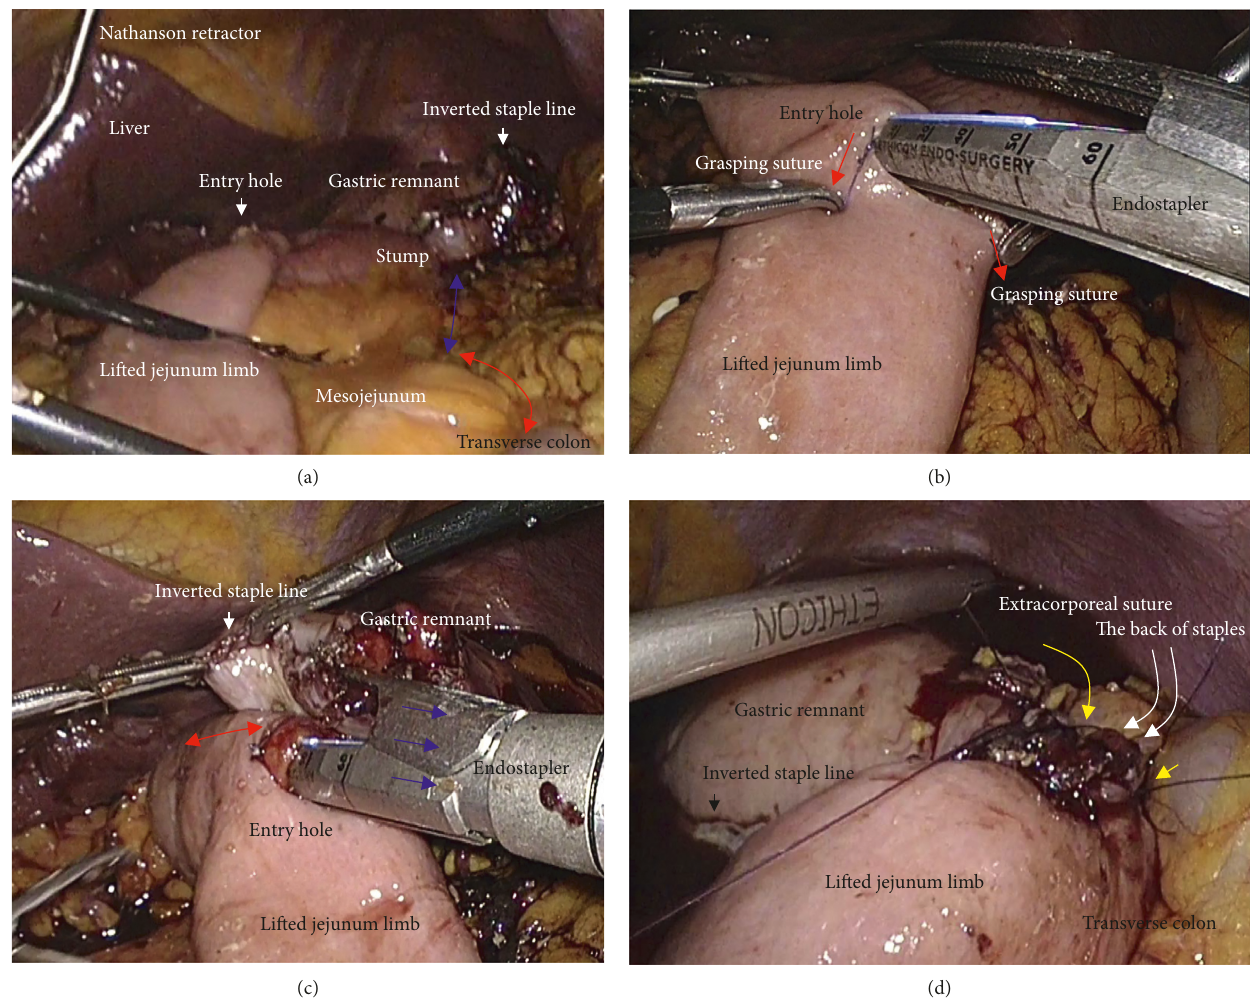
Figure 5: Actual findings via laparoscope during intracorporeal procedures were shown. Co-author, (T) Hori, mainly performed this surgery. (a) Two full-thickness anchor sutures (red arrows) were bilaterally placed for secure closure of the entry site. (b) Mucosal layers at the entry site were closed (red arrow). (c) Seromuscular layers at the entry site were closed. (d) Seromuscular sutures were made to cover the back of staples (yellow